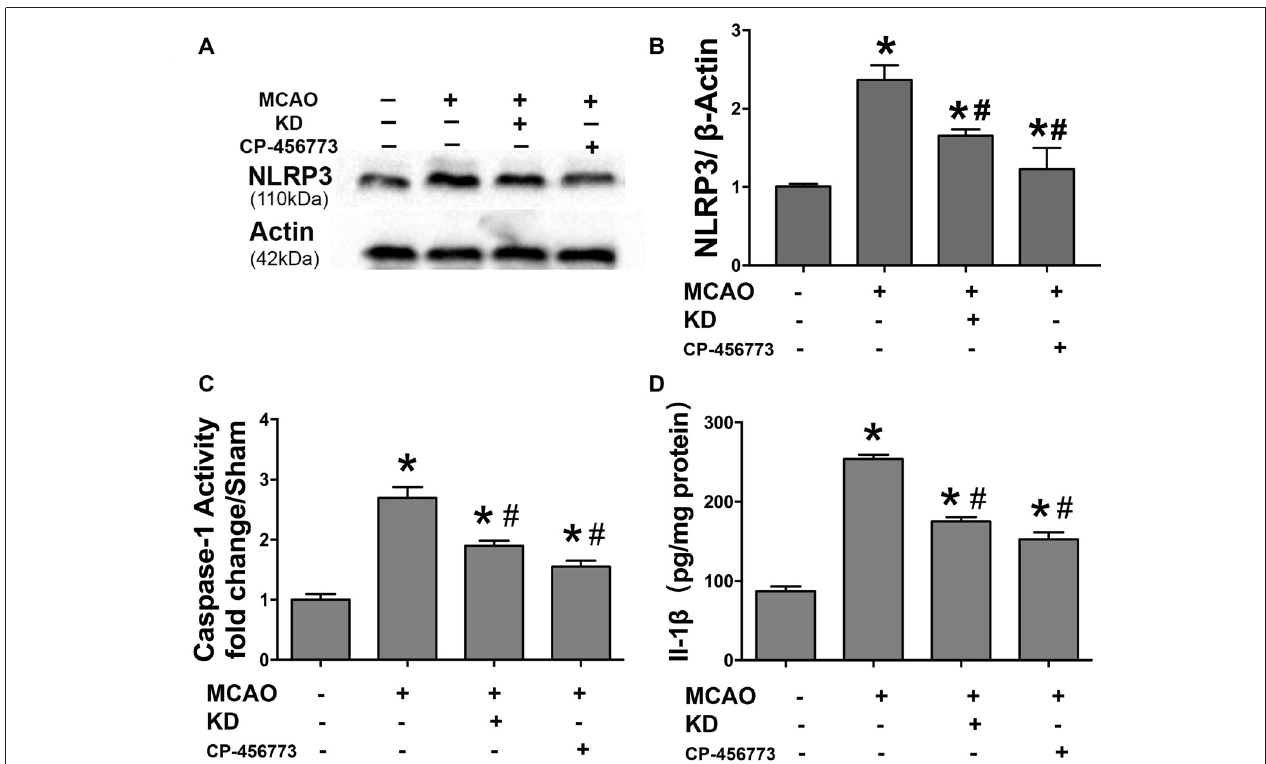
FIGURE 3 | NLRP3 inflammasome inhibitor CP-456773 suppressed NLRP3 mediated inflammation response in MCAO mice. (A,B) Sham-operated and MCAO mice ( n = 6 per group) were fed with different diet protocols and the protein expression of NLRP3 was detected by Western blotting. Representative blots from six independent experiments with similar results are shown. Caspase-1 activity (C) and IL-1 β concentration (D) were detected by ELISA. Caspase-1 activity was determined on brain lysates and compared to that in sham-operated mice. IL-1 β production is expressed per mg of total protein in brain tissue lysates. Data are shown as mean ± SEM; ∗ P < 0.01 vs. sham-operated mice, # P < 0.05 vs. MCAO